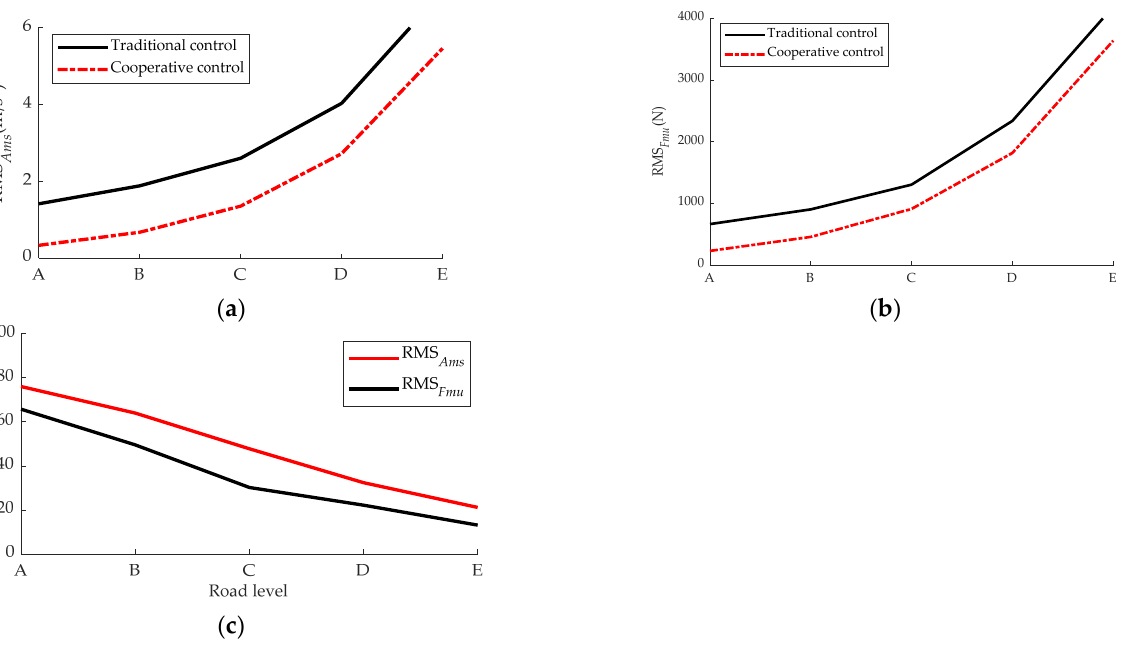
RMS fmu between traditional control and cooperative control. ( c ) Improvement rate of RMS Ams and